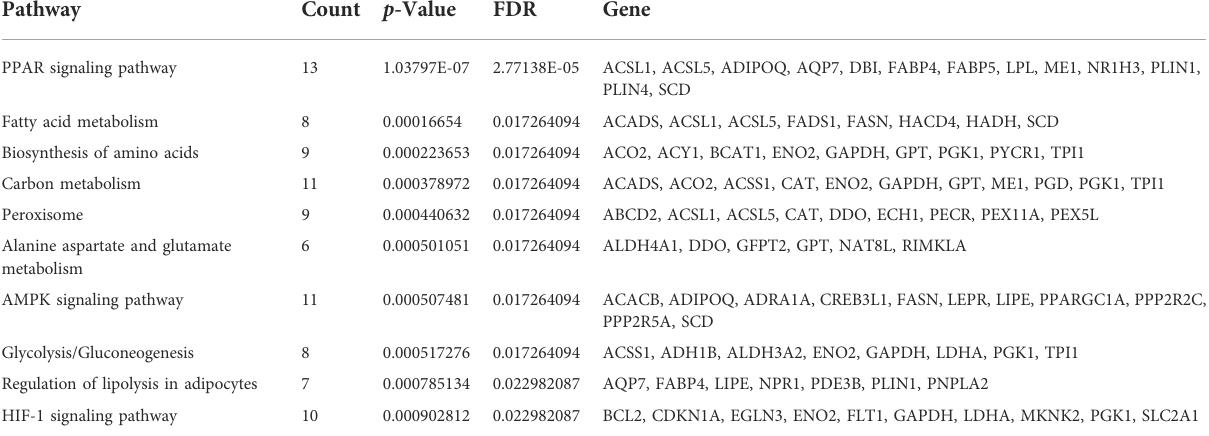
TABLE 4 The top 10 pathways with largest signi fi cant difference in KEGG